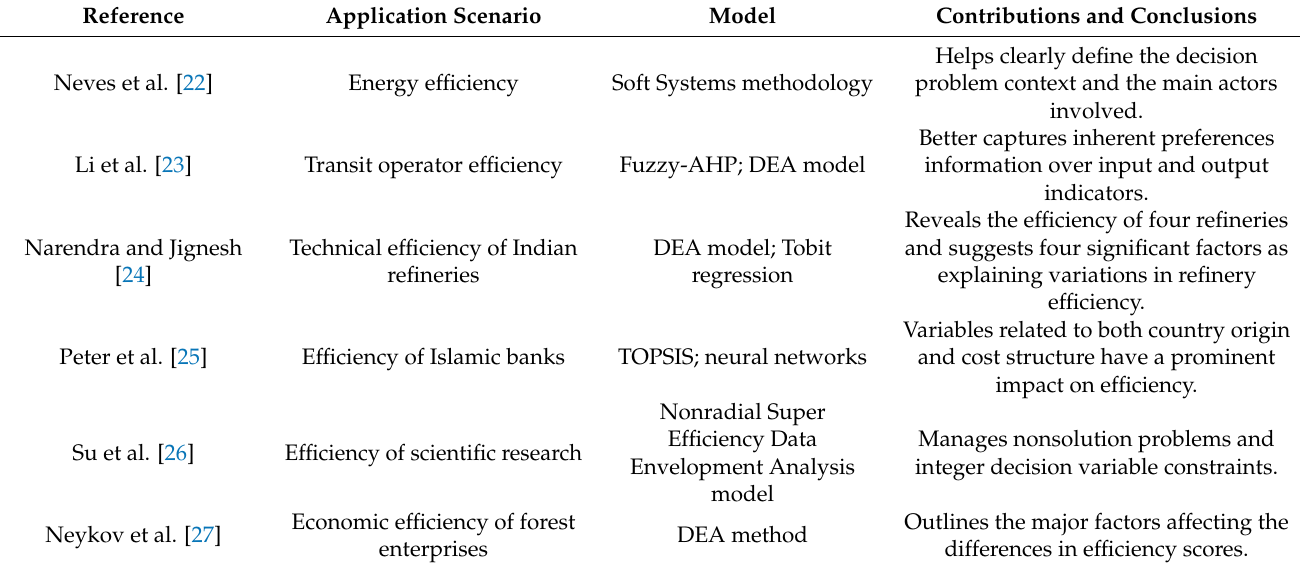
Table 1. The research about efficiency measurement in different